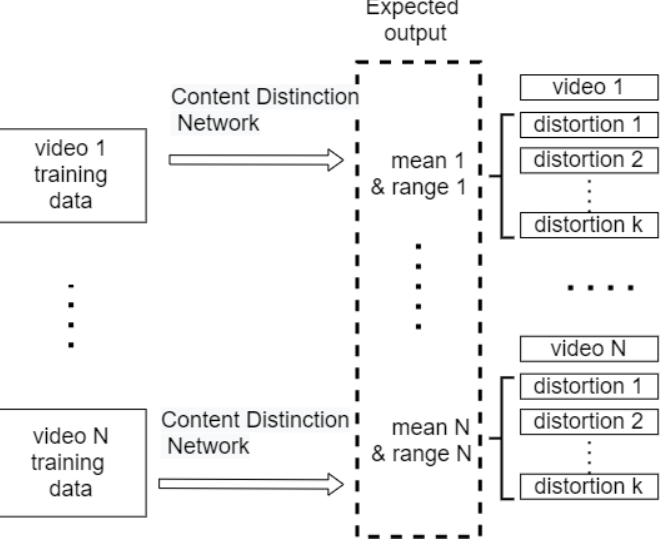
Figure 8. Content distinction network learning